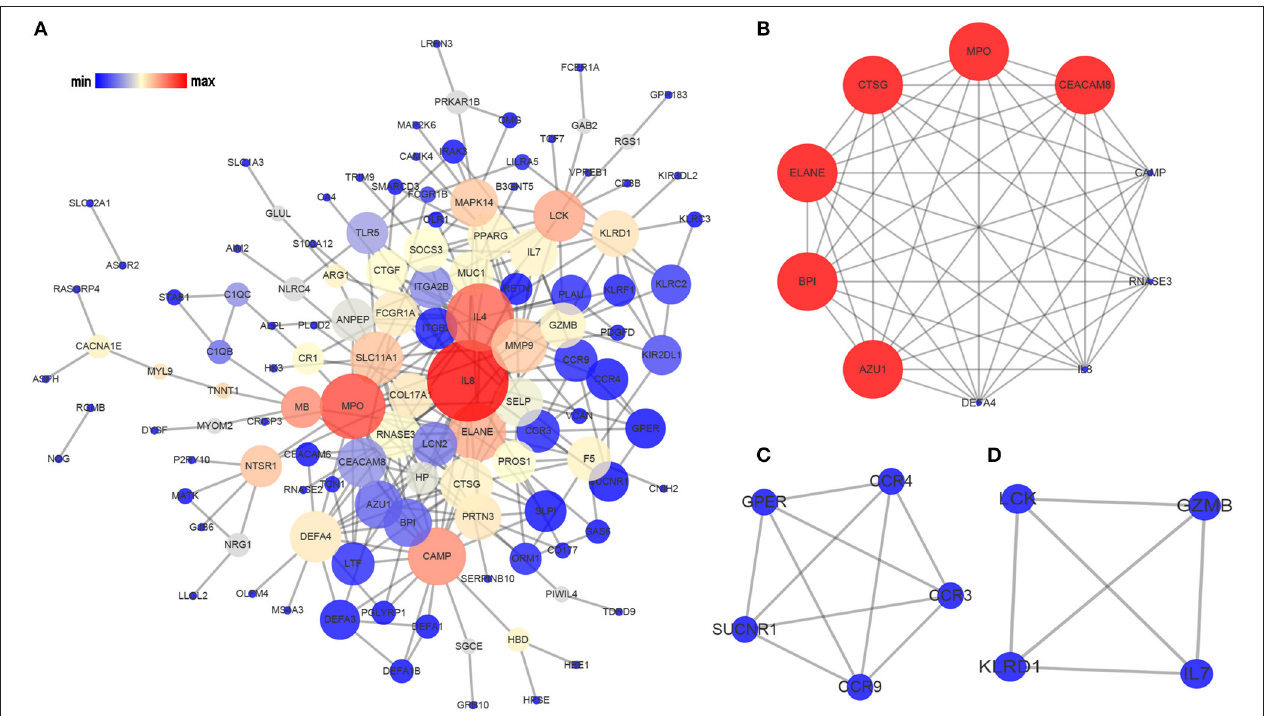
FIGURE 2 | Analysis of the PPI network of the SARGs. The nodes represent the SARGs in the PPI network, and the lines show the interaction between the SARGs. (A) PPI network of the SARGs. (B) module 1. (C) module 2. (D) module 3. The node size correspond to degree of the node, while the node color denotes betweenness